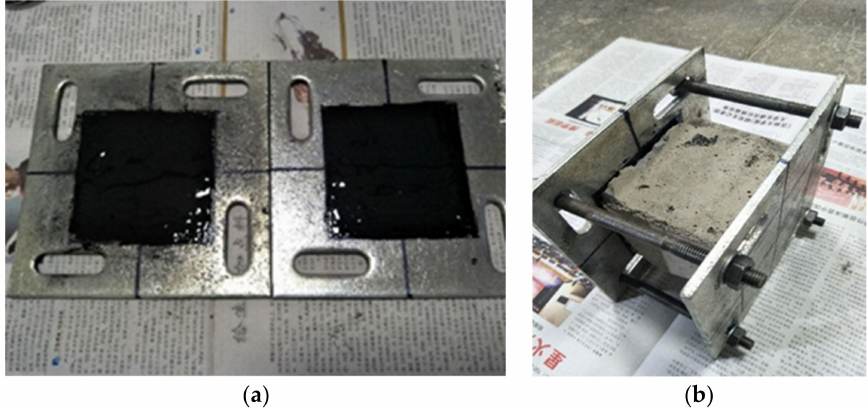
Figure 9. Concrete penetrometer and split specimen after the impermeability test. ( a ) Concrete penetrometer; ( b ) split specimen after the impermeability